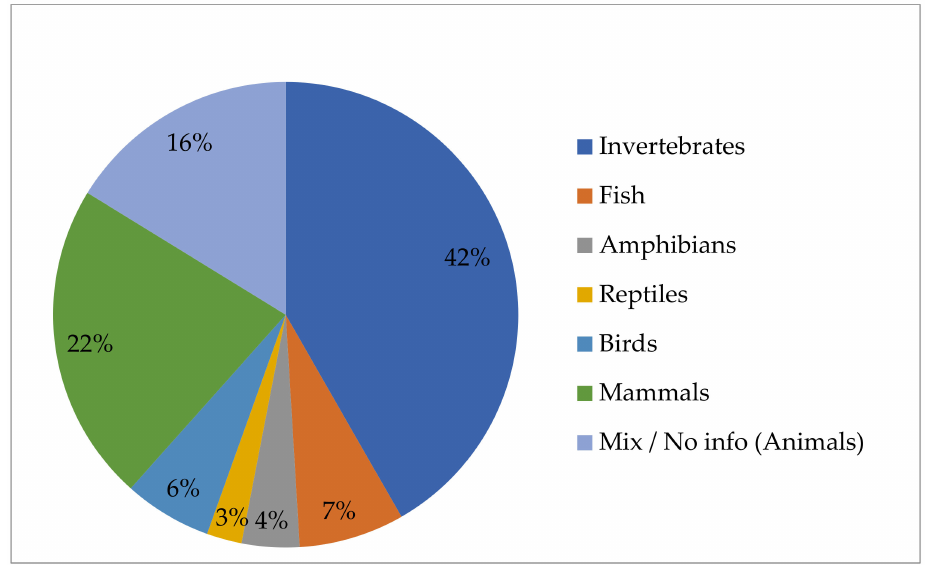
Figure 4. Distribution of IRCC with animal genetic/biological resources, as the subject matter, as of 31 May